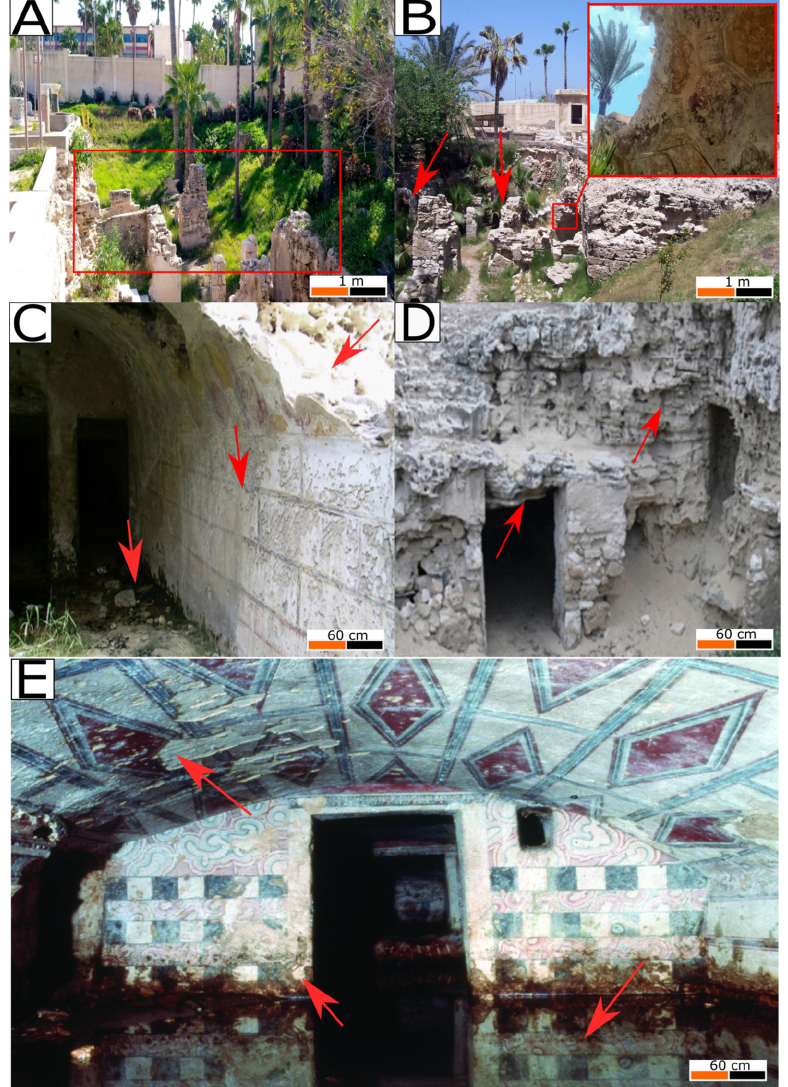
Figure 12. ( A , B ) Structural damage aspects due to earthquakes. ( A ) The red rectangle refers to the deformations in the structures. ( B ) The red arrows refer to collapse and displacement of the blocks and opened joints, and the red square refers to the damage to walls with chipping. ( C ) Water intrusion impact on the architectural and structural elements of Anfushi’s Necropolis. Red arrows refer to biological growth, salt accumulation, and degradation of the stone and painting layers. ( D ) Geotechnical problems and unconsolidated bedrock with many cavities, as shown by the red arrows. ( E ) Dampness impact over the structural and decorative elements of tomb No 5 (burial unit) at Anfushi’s Necropolis. Red arrows refer to flaking, salt erosion, and biological attack on the tomb’s construction materials [77].